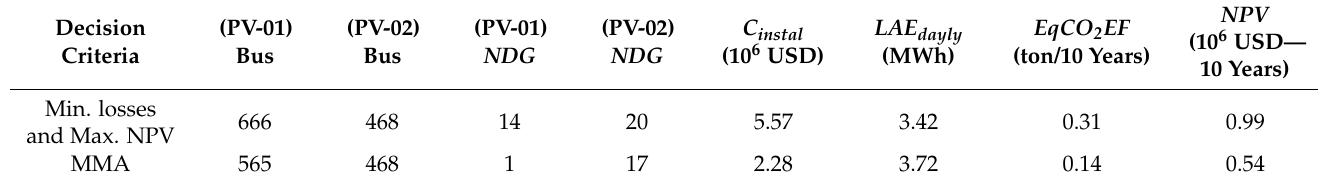
Table 4. Case study II: final solution phenotypes of minimum power losses, maximum NPV and MMA decision criteria.